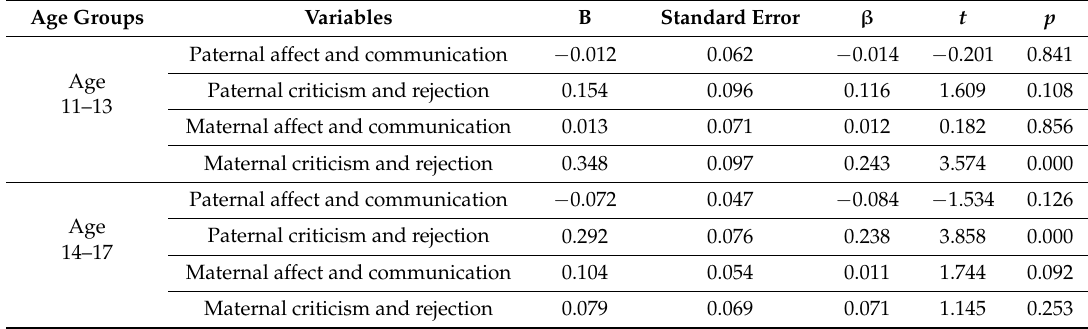
Table 2. Factors associated with emotional instability based on linear regression analysis, controlling for